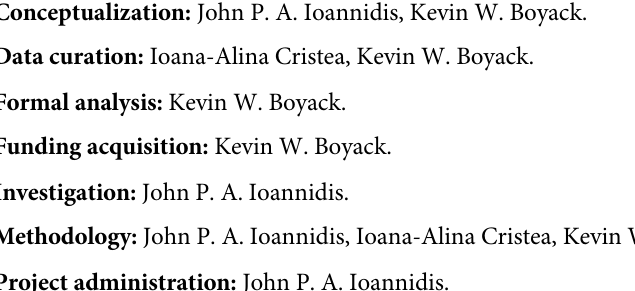
S1 Table. Selected key papers for Nobel prizes in Physics, Chemistry, and Medicine/Physi- ology, 1995–2017. S2 Table. Number of papers in different fields published within one year of each Nobel paper that are more cited than the Nobel paper. S3 Table. 76 scientific domains that have had no key papers for the three types of Nobel